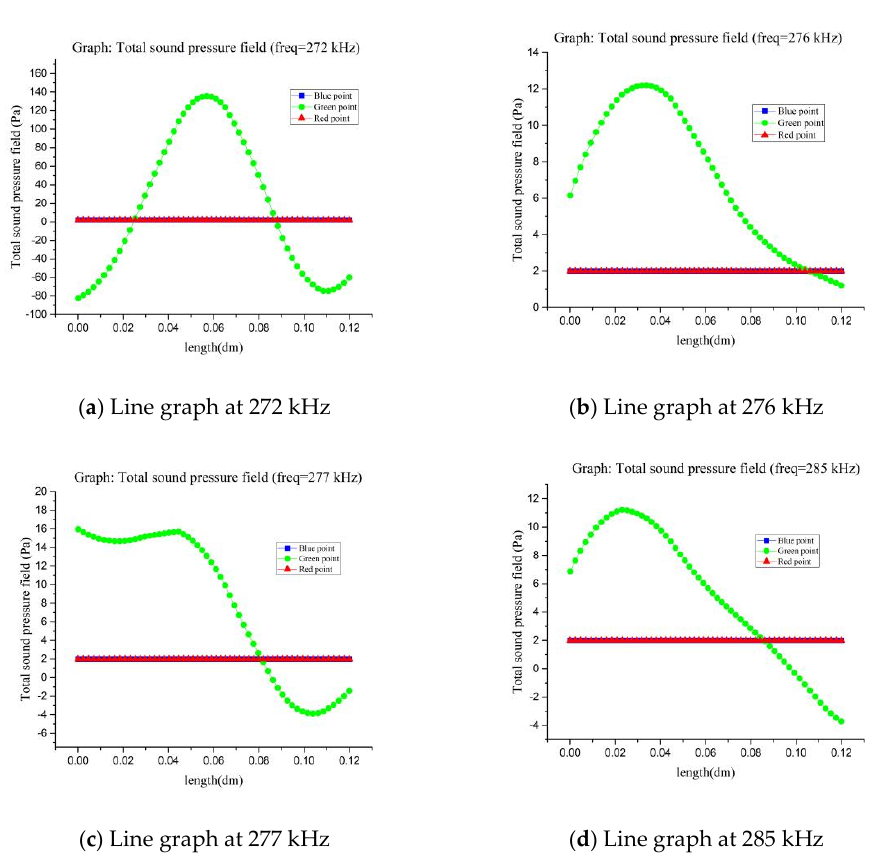
Figure 5. Sound pressure changes of acoustic waves at different frequencies: ( a ) Line graph at 272 kHz; ( b ) line graph at 276 kHz; ( c ) line graph at 277 kHz; ( d ) line graph at 285 kHz.